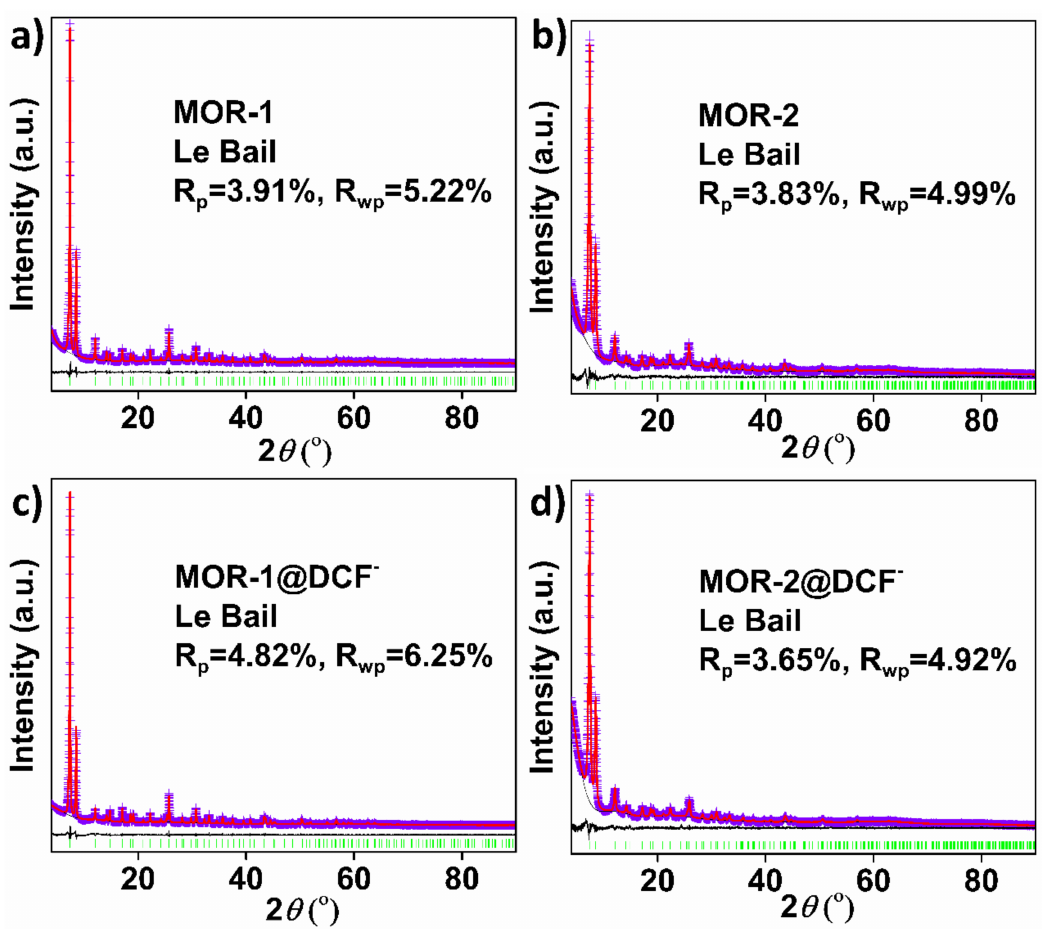
Figure 6. Le Bail plot of ( a ) MOR-1 , ( b ) MOR-2 , ( c ) MOR-1@DCF − , and ( d ) MOR-2@DCF − . Cell indexing data from Le Bail refinement: MOR-1 (space group Fm -3 m ): a = 20.785(4) Å, V = 8979(6) Å 3 ; MOR-2 (space group I 4 /m ): a = 14.631(5) Å, c = 20.743(9) Å, V = 4441(4) Å 3 ; MOR -1 @DCF − (space group Fm -3 m ): a = 20.771(3) Å, V = 8962(5) Å 3 ; MOR -2 @DCF − (space group I 4 /m ): a = 14.59(1) Å, c = 20.64(1) Å, V = 4391(9) Å 3 . Blue crosses: experimental points; red line, violet crosses: experimental points; red line: calculated pattern; black line: difference pattern (exp-calc); green bars: Bragg